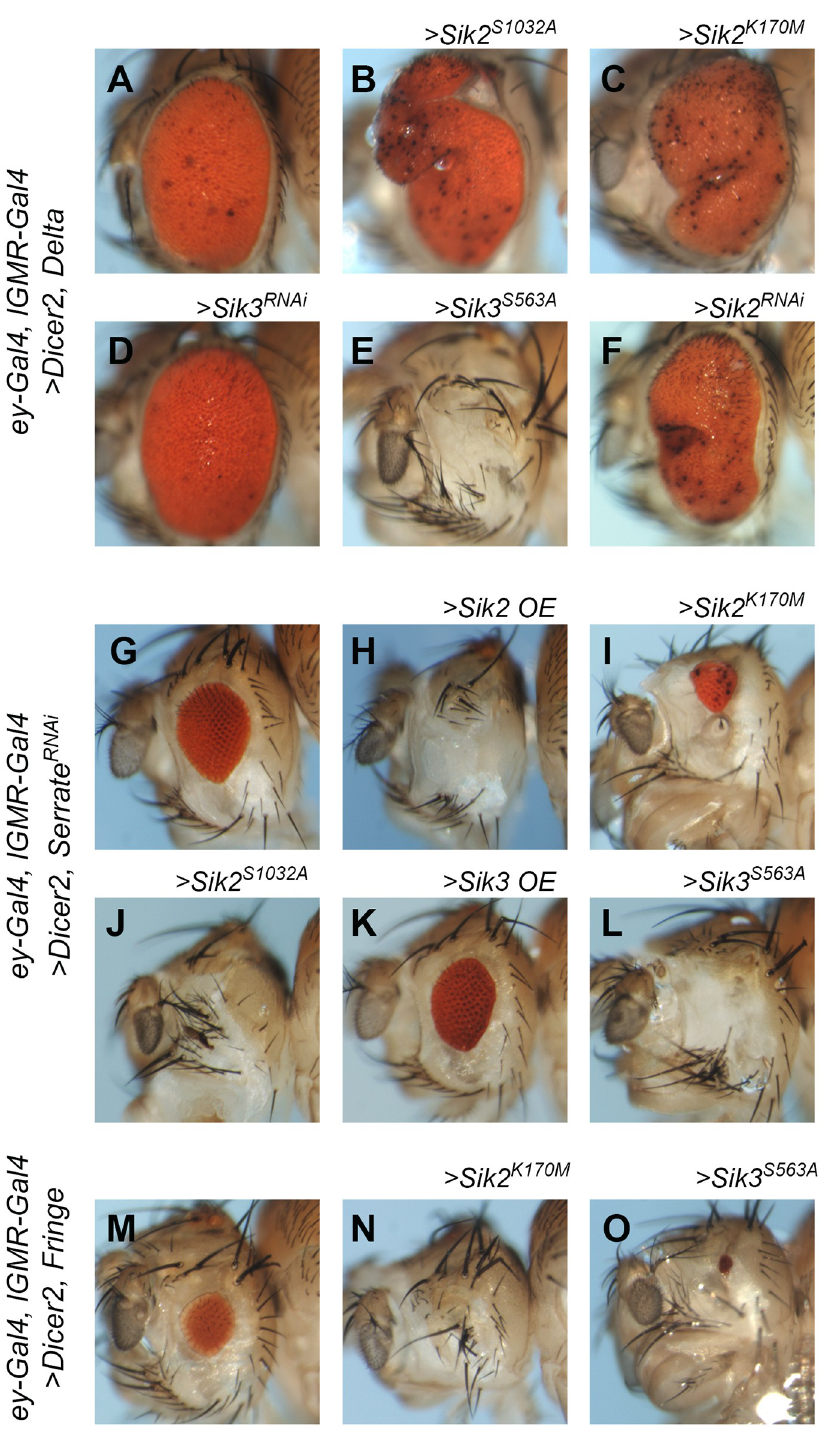
Fig 3. Genetic interaction between sik transgenes and Notch pathway members. (A-F) Delta overexpression with strong eye specific driver ( UAS-Dicer2 / UAS-Delta; ey-GAL4 , lGMR-GAL4 / + ) in combination with overexpression of Sik transgenes and RNAi depletion. (A) Control. (B) Sik2 constitutively active ( > Sik2 S1032A ); example of overgrowth and necrosis. (C) Sik2 kinase-dead ( > Sik2 K170M ); example of overgrowth and necrosis. (D) Sik3 knock-down ( > Sik3 RNAi ). (E) Sik3 constitutively active ( > Sik3 S563A ); example of total eye loss. (F) Sik2 knock-down ( > Sik2 RNAi ). (G-L) Serrate knock-down with strong eye specific driver ( UAS-Dicer2 / +; ey-GAL4 , lGMR-GAL4 / +; Serrate RNAi / + )